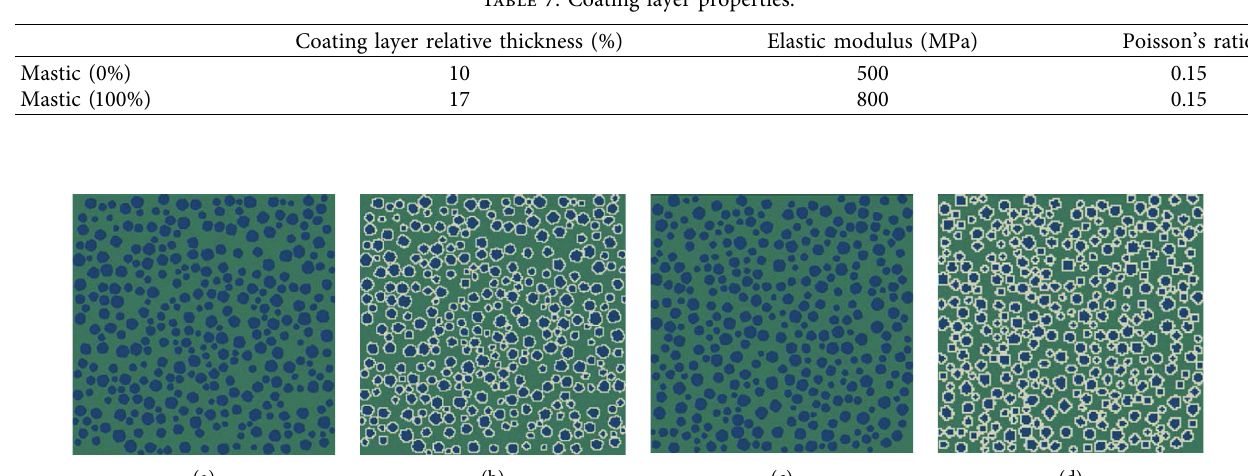
Table 7: Coating layer properties.